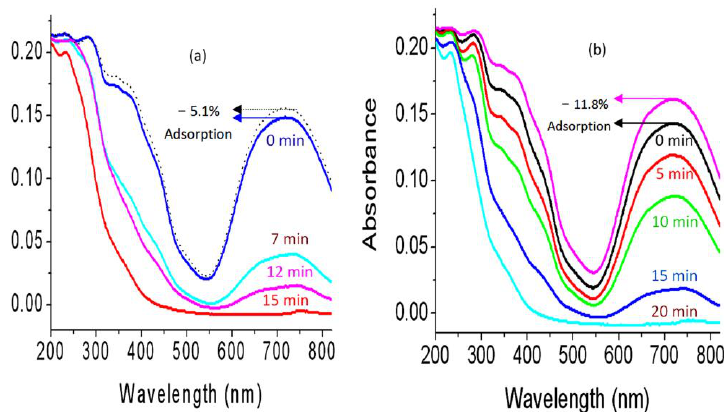
Figure 12. Photocatalytic degradation of Naphthol green B in presence of: ( a ) NHZ-1-500 and ( b ) ZNH-2-500.